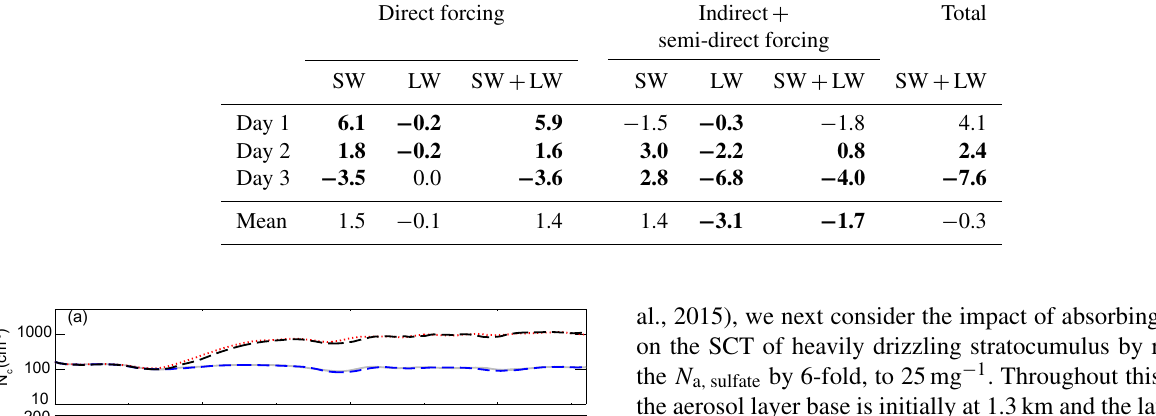
Table 9. As in Table 2 but for a lightly drizzling baseline with a moisture perturbation aloft. Boldface indicates results exceeding the uncertainty range derived from the spread of the lightly drizzling baseline ensemble. Direct forcing Indirect + Total